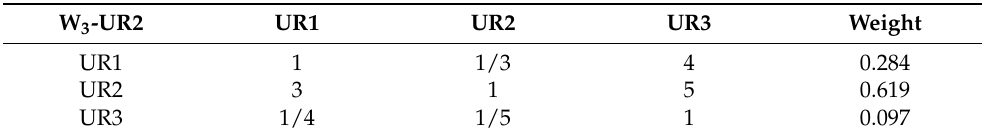
Table A4. Calculating relative weights of URs interms of UR2 through pairwise comparison to determine W3.